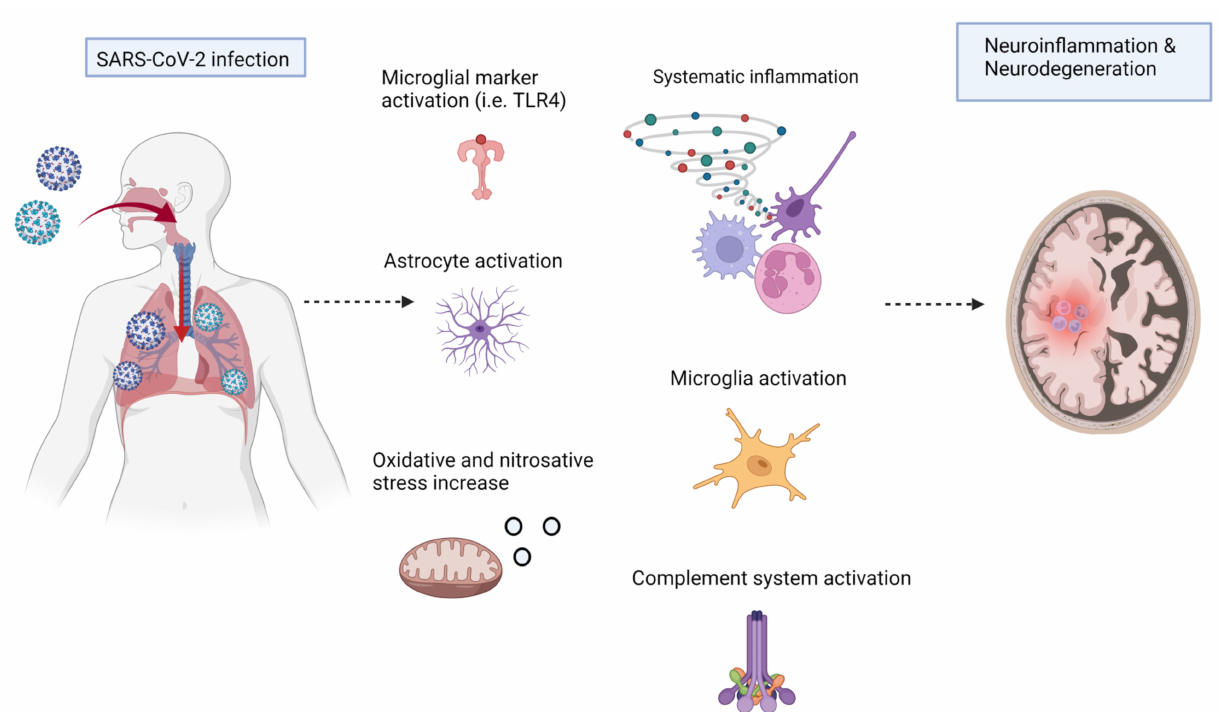
Figure 5. Shared pathological features of COVID-19 and neurodegeneration. The figure, showing the main pathological features of COVID-19 and neuroinflammation, consisted of activating the innate immune system, activation of microglial and astrocytic cells, activation of the complement system, and release of the inflammatory cytokines. TLR: toll-like